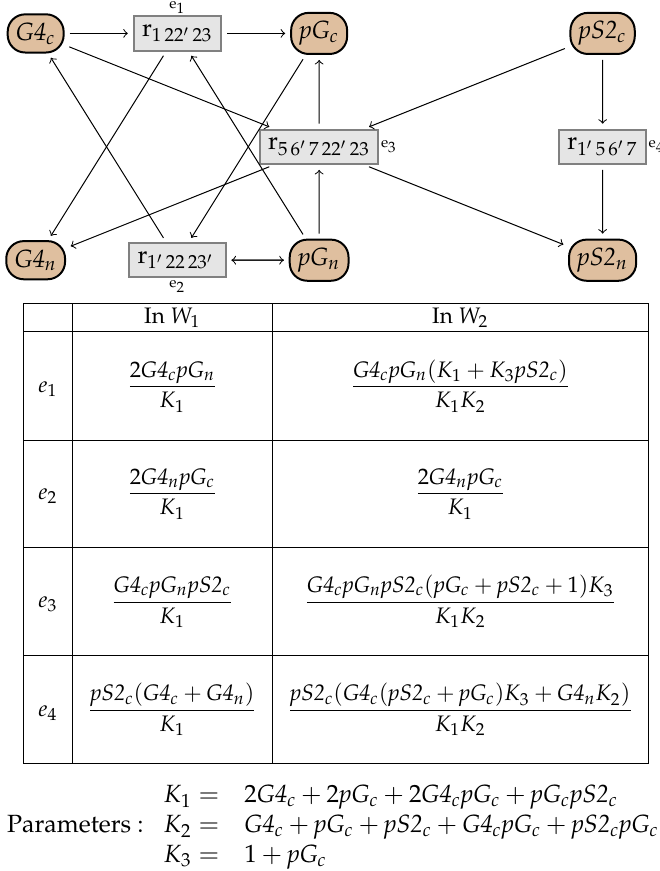
Figure 25. Simplified networks from W . Both networks have the same structure, and the kinetic expressions are defined in the table. The network W 1 is obtained by removing in order S4 n , S24 n , S24 c , S4 c and the dependent fluxes. The network W 2 is obtained by removing in order S4 n , S24 n , S4 c , S24 c and the dependent